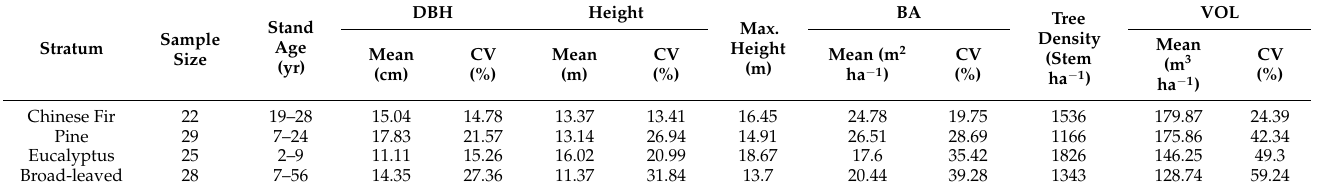
Table 1. Summary of field measurements of the 900 m 2 field plots. CV is the coefficient of varia- tion.